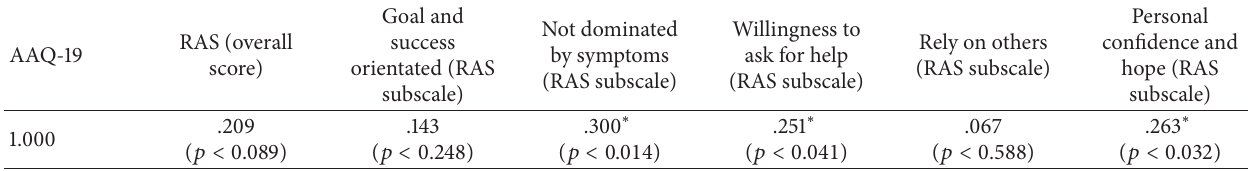
Table 1: Correlations between the AAQ-19 and the RAS and its subscales.